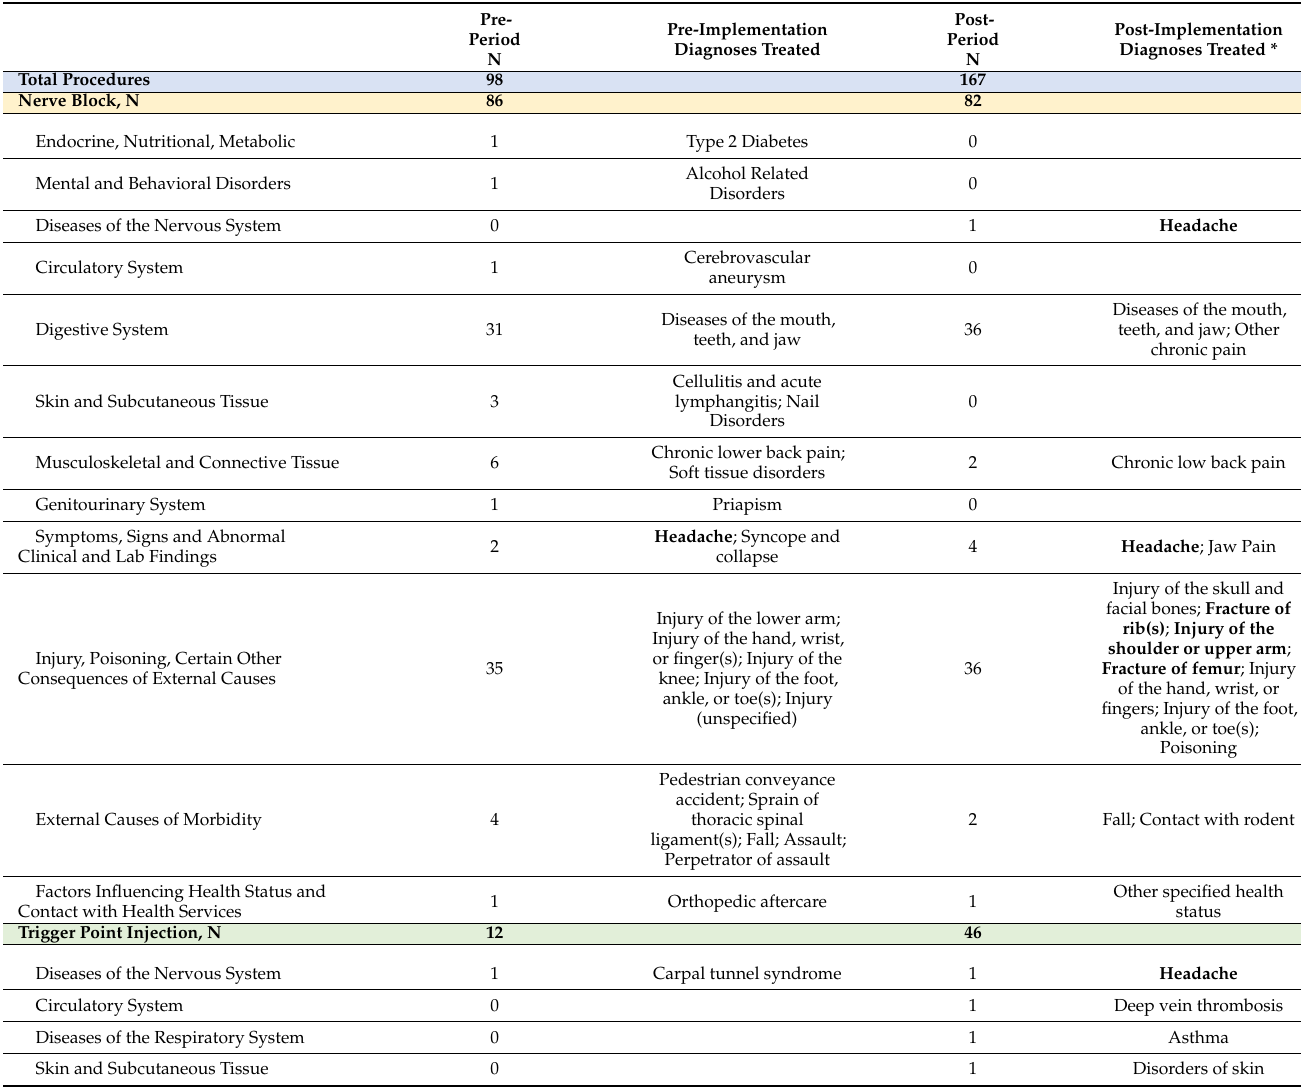
Table 3. ED-ALTO Alternative Procedure Utilization in the Pre- and Post-implementation Periods by Diagnoses